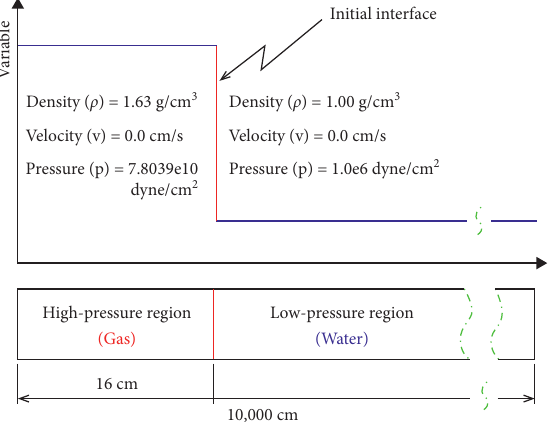
Figure 17: Initial conditions of Case